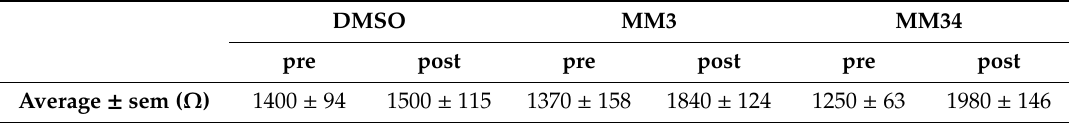
Table 1. Transepithelial electrical resistance (TEER) measured in Cystic fibrosis (CF)-human bronchial epithelial cells (HBEC) before and after the treatment with the